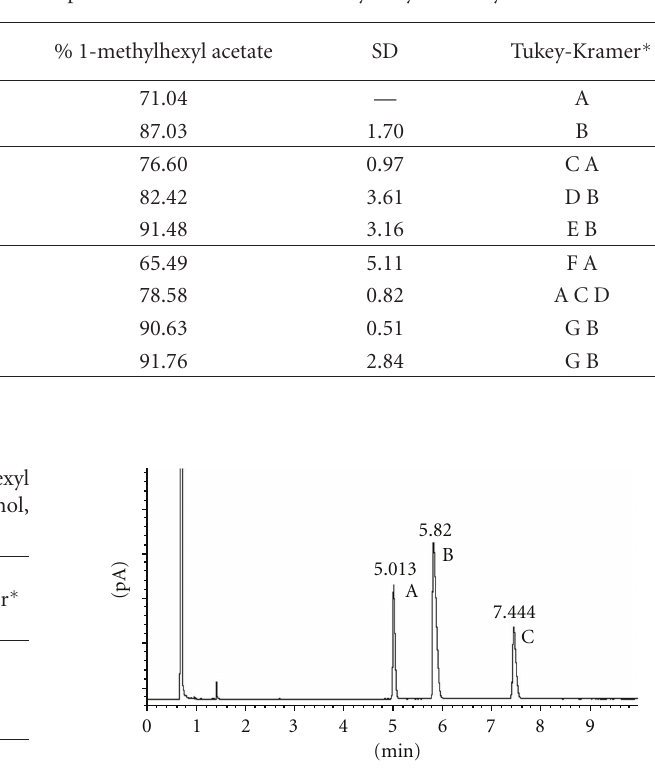
Table 2: Influence of reaction time and molar ratios 2-heptanol :acetic acid in the 1-methylhexyl acetate yields.